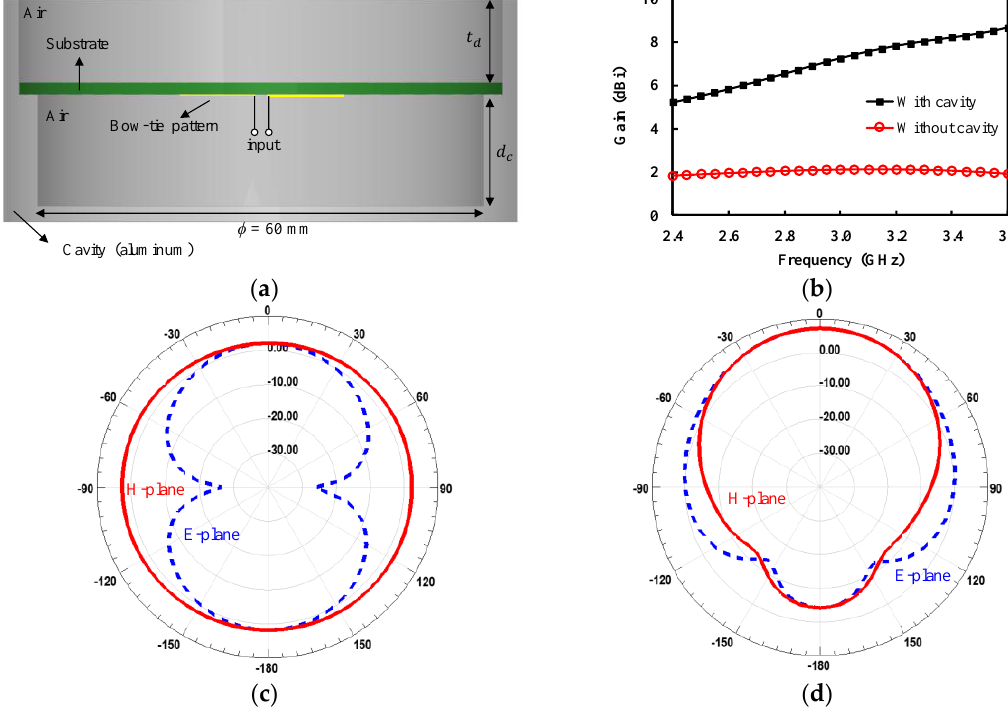
Figure 2. Cavity-backed bow-tie antenna ( a ) cross-sectional view; ( b ) simulated gain of the antenna with and without the cavity; ( c ) simulated gain of the antenna without the cavity; ( d ) simulated gain of the antenna with the cavity.